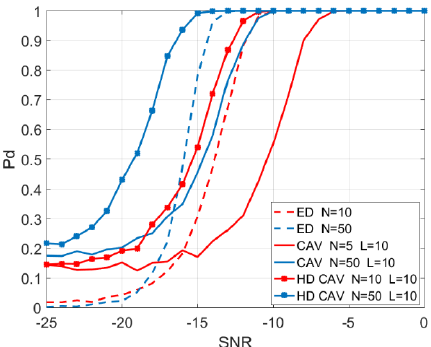
Figure 7. The probability of detection in a SNR function for HD CAF (with uncertainty of spectral density of noise power estimation influence)